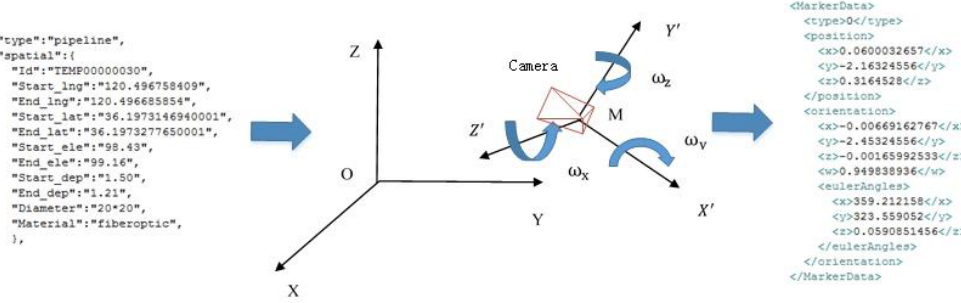
Figure 3. Coordinate conversion from spatial rectangular coordinate system to world coordinates.